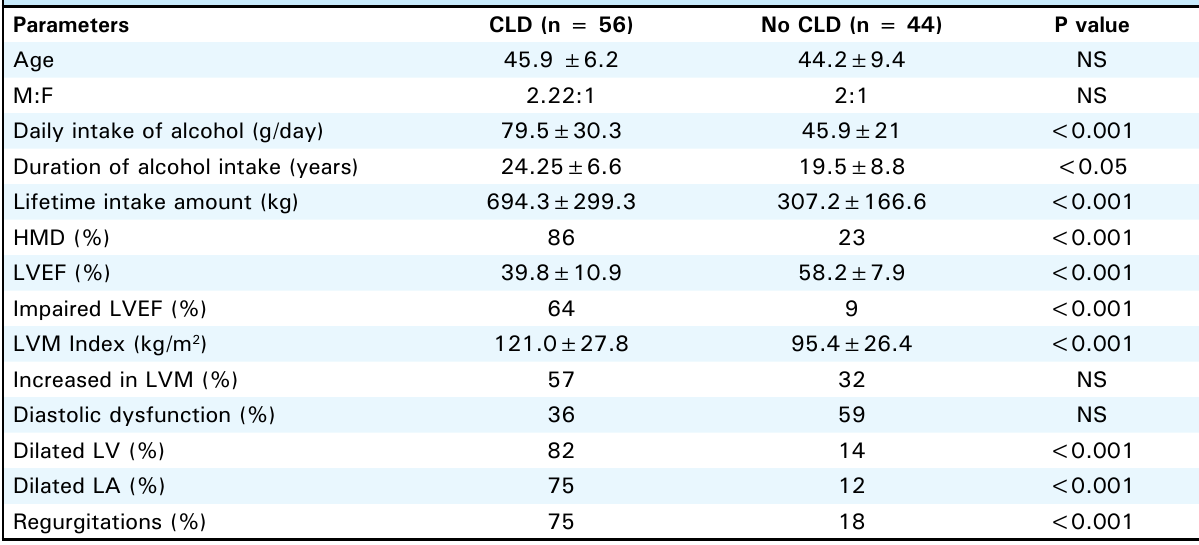
Table 2. Various drinking parameters in subjects with CLD and without CLD.